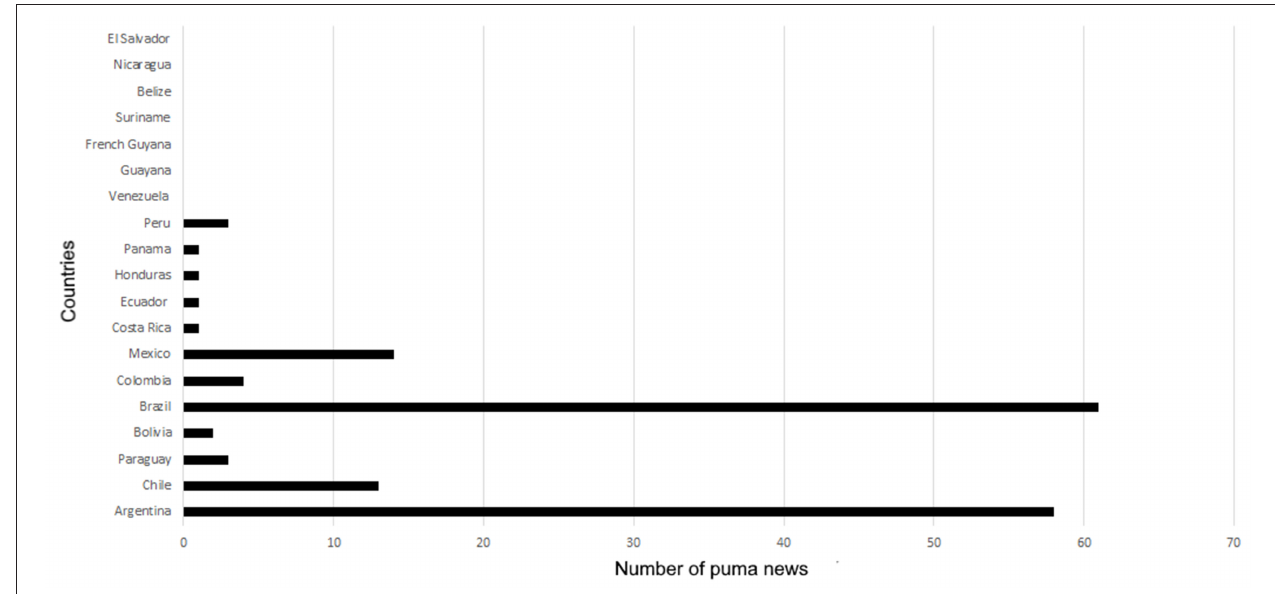
FIGURE 4 | Distribution of the puma events across the countries of Latin